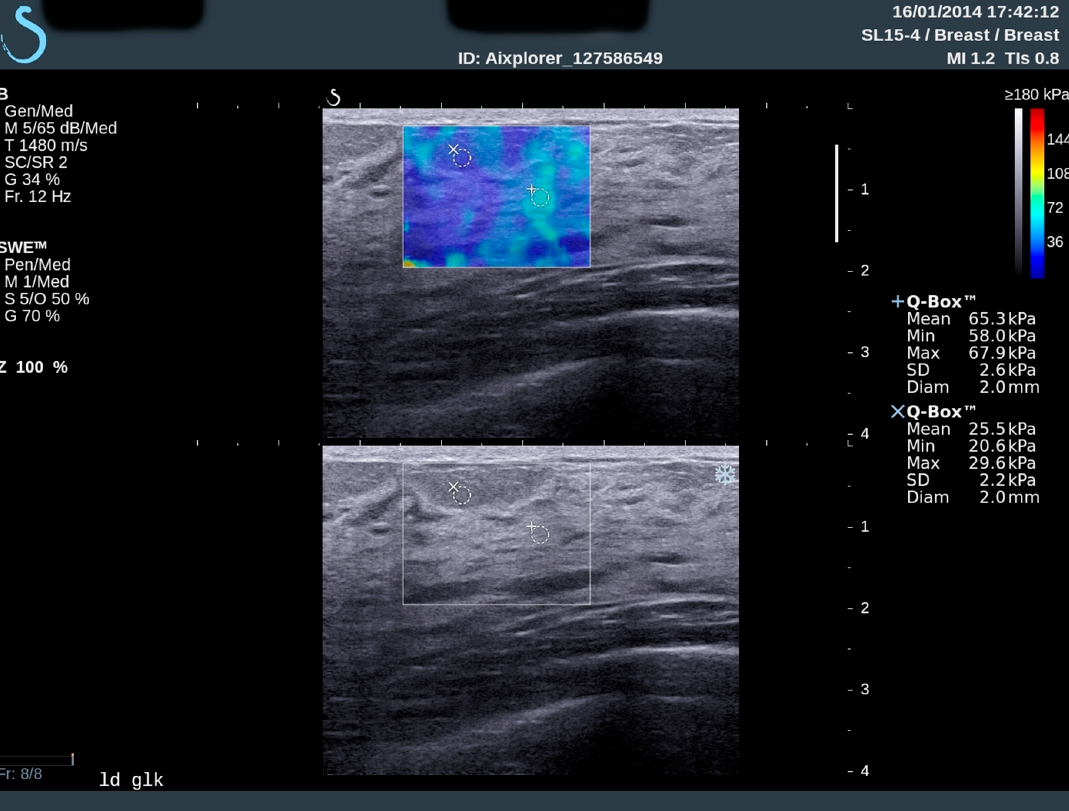
Figure 1. Elastography measurement. Region of interest is placed into representative place for fatty and glandular breast tissue. Ultrasound device shows elasticity values in color and kPa.